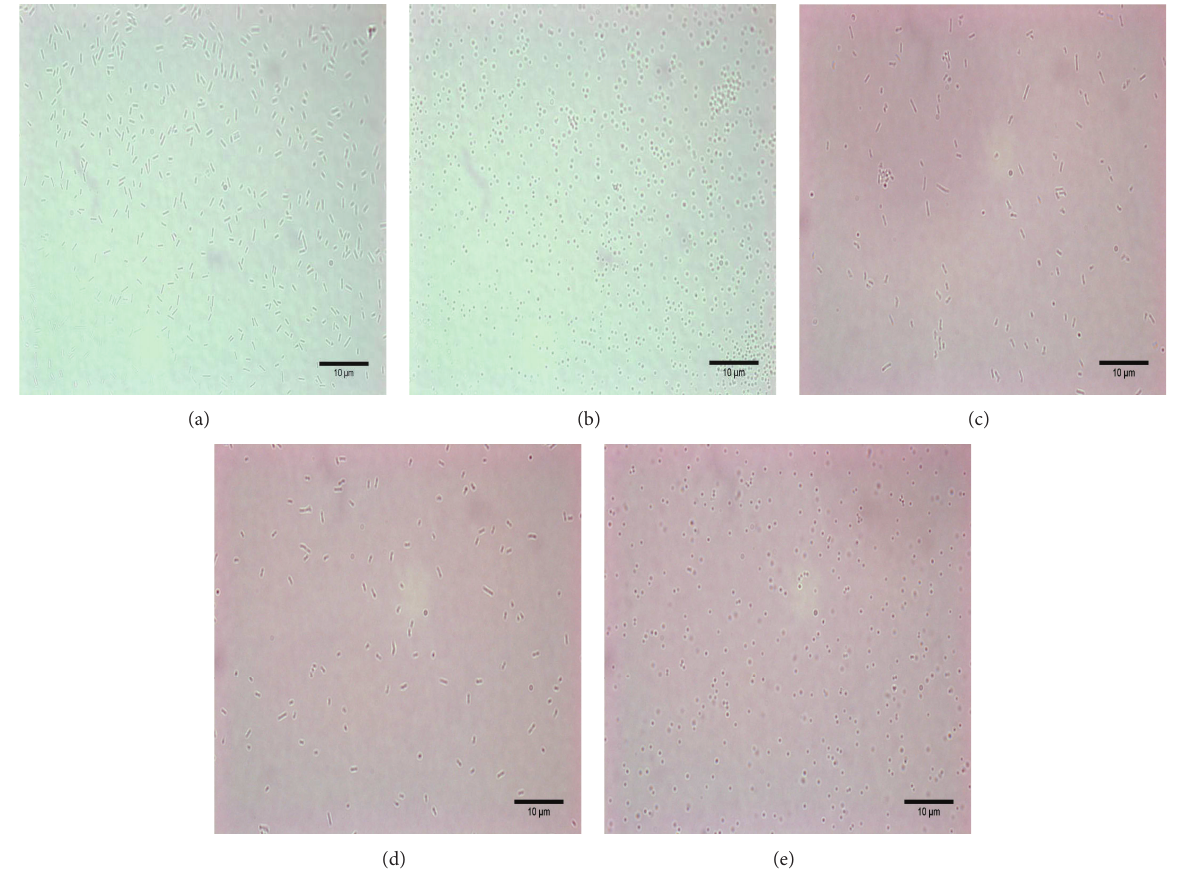
Figure 2: Morphological changes to the cells during the transformation process. As there was no transformation protocol available for the genus of Natrinema , we used the transformation process used for Hfx. volcanii . All procedures were performed at room temperature. We picked out a single colony of J7-2 and cultivated it in liquid MGM media at 42 ∘ C. Selected cultures of J7-2 were obtained and treated with spheroplasting solution for 15min, while some were not treated to provide a control. Cell morphology was observed and recorded under the microscope. The results are shown in (a) and (b). During the recovery process, three different regeneration solutions were tested to determine whether the cell morphology could be recovered to short rods and which medium was more suitable for Natrinema : H-2 medium, 18% MGM and regeneration solution. We modified the protocol slightly. The regeneration time was changed from 20–30 min at RT to 2 to 5 hours at 37 ∘ C and the transformation solutions were also changed from 1M NaCl to 2 M NaCl. The regeneration results were also observed and recorded under microscope. All recovered results are shown in (c), (d), and (e). (a) Cells of J7-2 grown in MGM medium before spheroplasting solution treatment. (b) Cells of J7-2 treated with spheroplasting solution. (c) Cells of J7-2 regenerated with H-2 medium treatment. (d) Cells of J7-2 regenerated with 18% MGM medium treatment. (e) Cells of J7-2 regenerated with regeneration solution